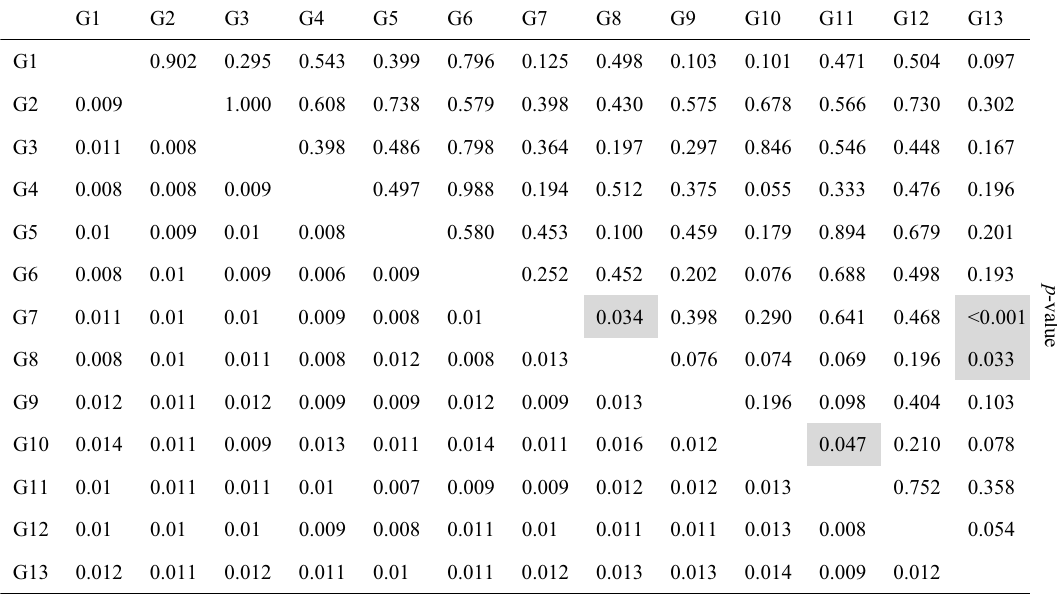
Table 2. Morphological distances of yellow-legged hornets from 13 sampling sites. Right value represents paired p values of Procrustes distances that were obtained using canonical variate analysis (CVA) after 10,000 permutation rounds among yellow-legged hornets from 13 sampling sites, and left value represents paired Procrustes distances from CVA. Significantly different distances are indicated by gray